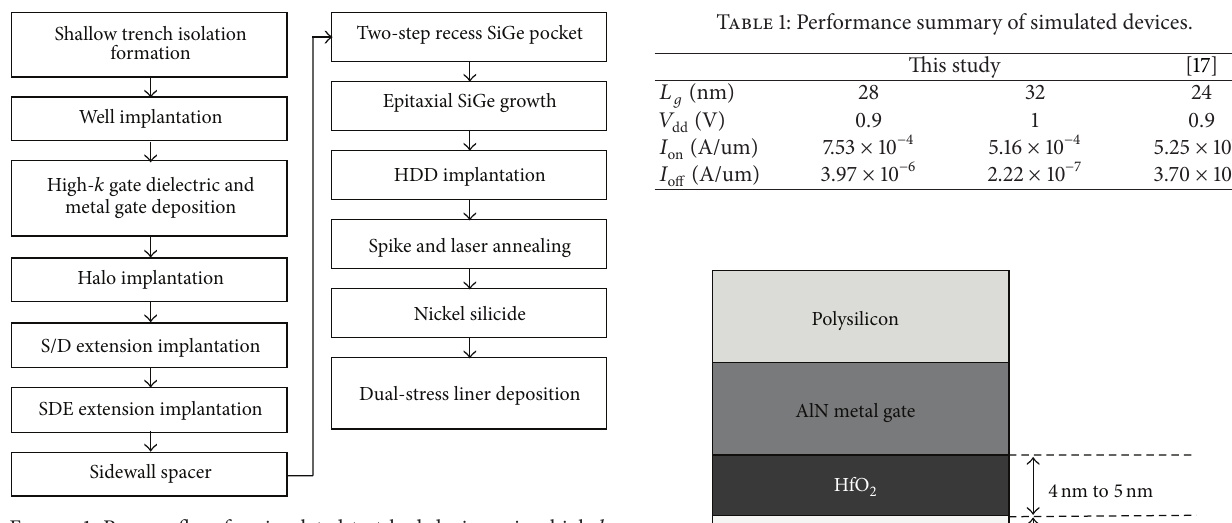
Figure 1: Process flow for simulated test bed device using high- 𝑘 metal gate process of the 32 nm technology node.